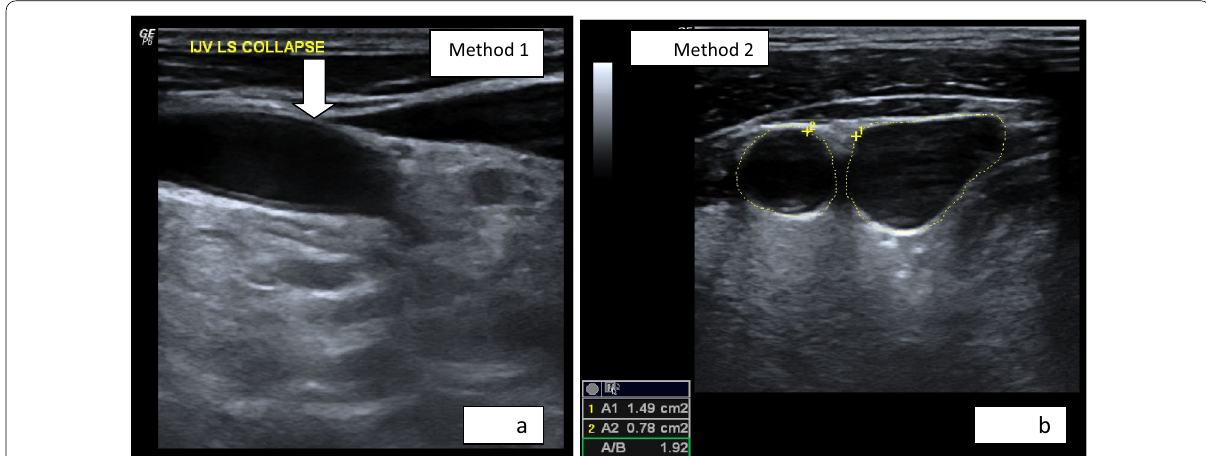
Fig. 4 Ultrasound images for A 49 years old female patient ( a ) a longitudinal ultrasound image for the collapsing point of the IJV (vertical white arrow) (method 1) and it was 7.6 cmH20 ( b ) transverse ultrasound image demonstrating the cross‑sectional areas (marked as dotted yellow lines by manual tracers) of the IJV ( 1.49 cm 2 ) and the CCA area ( 0.78 cm 2 ) and the ratio ( 1.92) (method 2). The Invasive CVP measurement (by the = = = catheter) was 7 cmH20